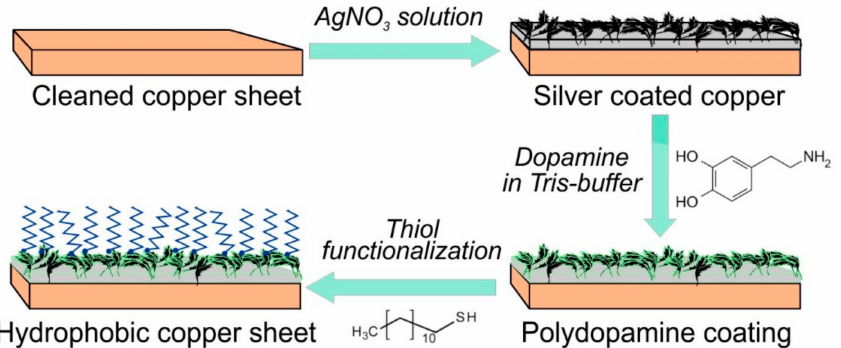
Figure 1. Schematic representation of the stages followed for the production of the hydrophobic silver coating on copper